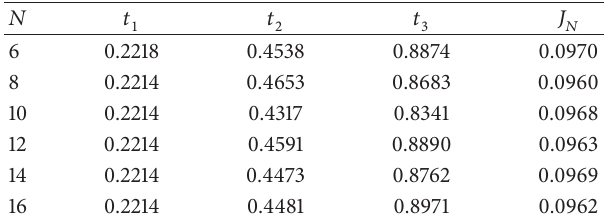
Table 1: Numerical results of Example